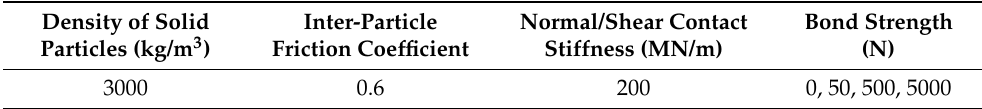
Figure 8. The particle size distribution of the models used in the current numerical (DEM) simulations in comparison with the physical models in the experimental study of Younessi et al. [29]. Table 2. DEM parameters used in the simulation of solid particles assembly.